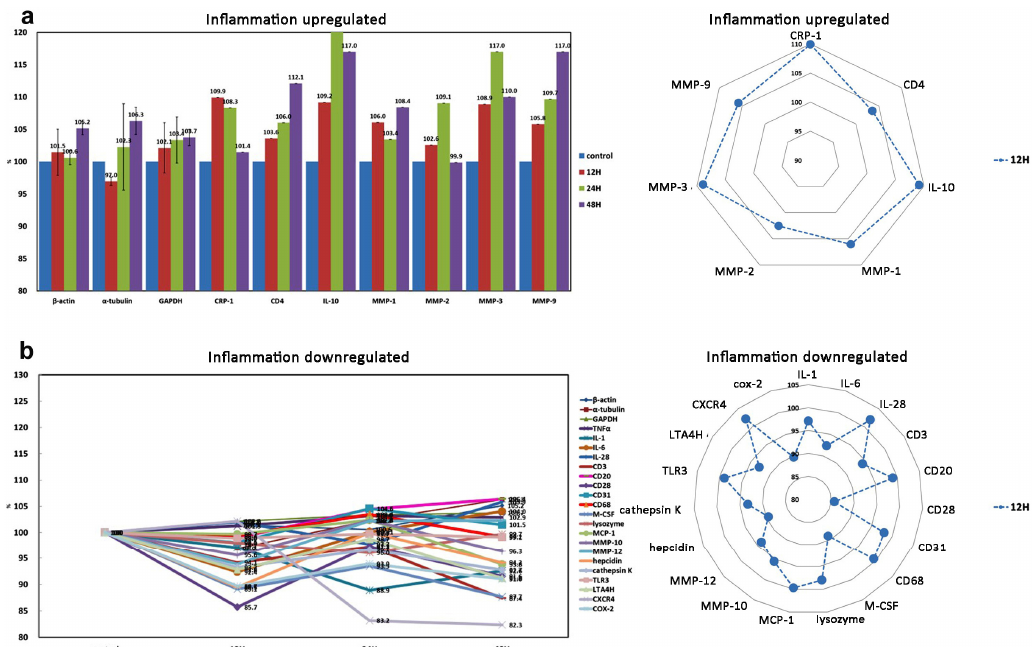
Figure 4. ( a ) Changes to immunity and inflammation-upregulated proteins after PTX treatment in RAW 264.7 cells. Left- sided graph shows changes to protein expression according to the application time of PTX, blue bar; control group, red bar; 12 h treatment of PTX, green bar; 24 h treatment of PTX, purple bar; 48 h treatment of PTX. Right-sided polygonal graph shows protein expression profiles after 12 h treatment of PTX. ( b ) Changes to immunity and inflammation down-regulated proteins after PTX treatment in RAW 264.7 cells. Left-sided line graft shows changes to protein expressions after PTX treatment over time. Right-sided polygonal graph shows protein expression profiles after 12 h treatment of PTX.